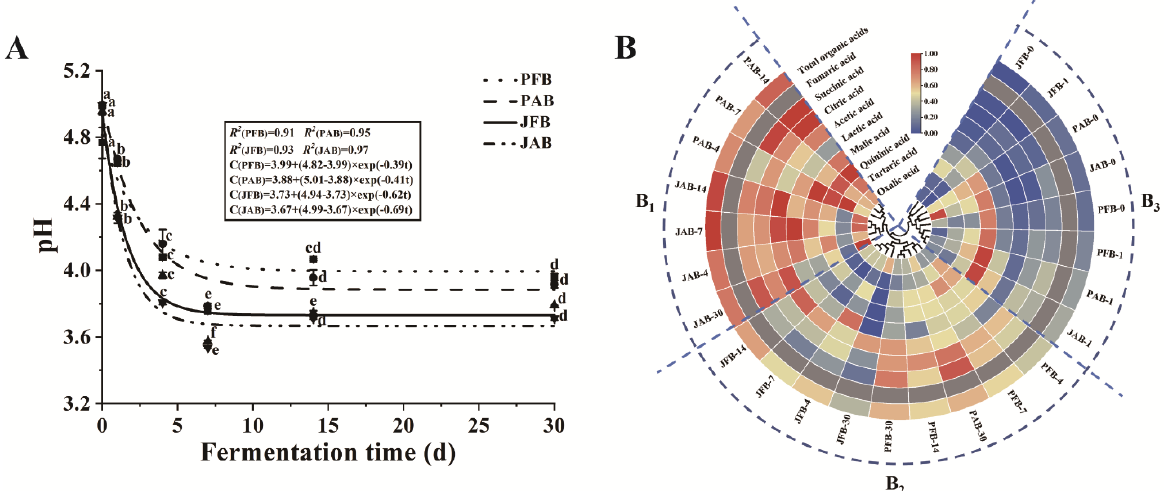
Figure 1. Changes in the pH value ( A ) and organic acids content ( B ) of pickled chili pepper based on different fermentation procedures, including PFB, PAB, JFB, and JAB ( n = 3). ( A ) pH value plot: the full lines represent the fitted values by kinetic modelling and the symbols represent the experimental data. Estimated parameters of the kinetic model were shown in the box. Different lowercase letters (a – f) indicated significant differences as a function of fermentation time ( p < 0.05). ( B ) Hierarchical clustering and heatmap visualization of organic acids: the color intensity was based on a normalized scale from a maximum of 1 (red) to a minimum of 0 (blue), which indicated the abundance of the organic acids among high (B 1 ), medium (B 2 ), and low (B 3 ).